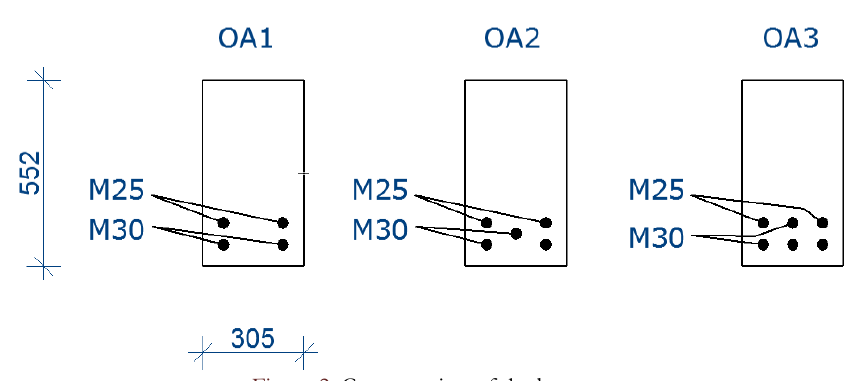
Figure 2: Cross-section of the beams.